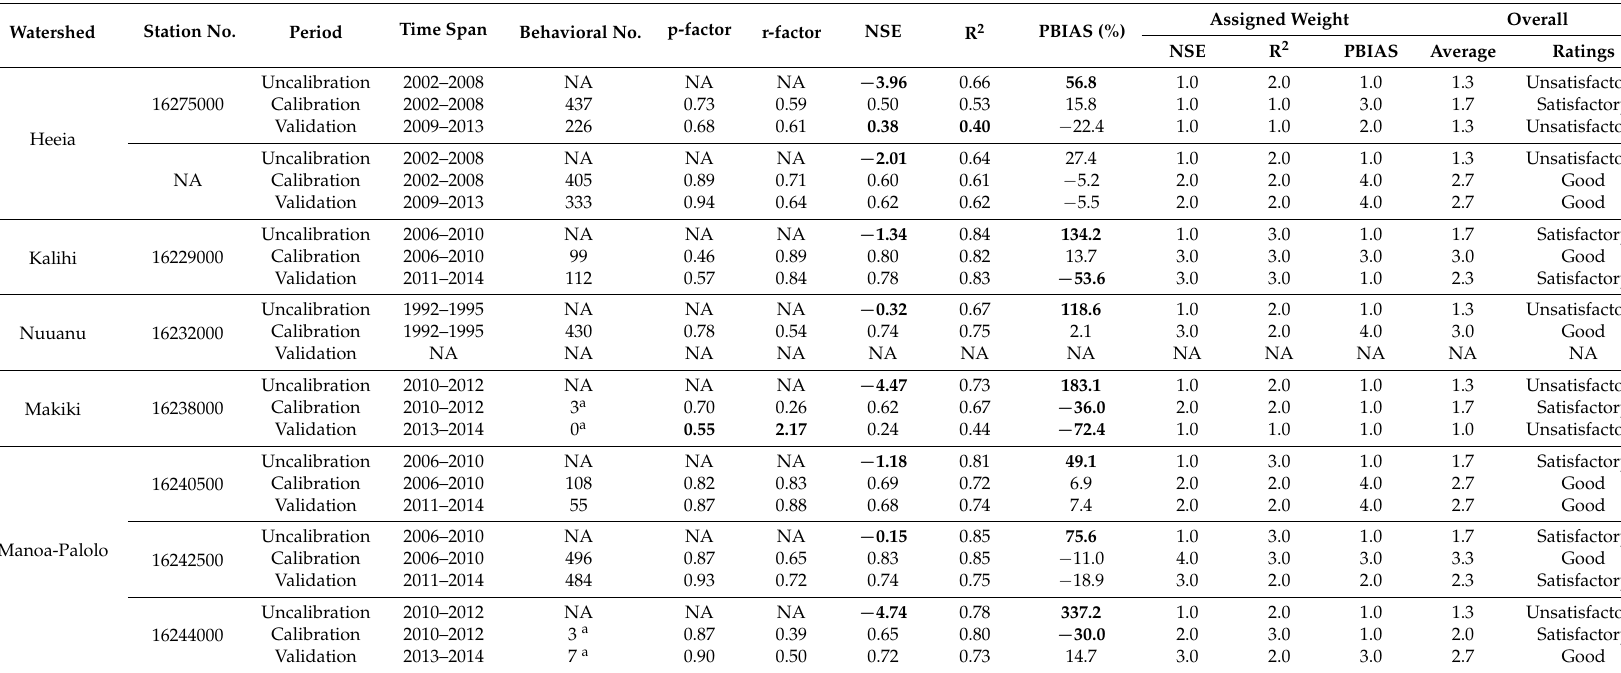
Table 6. Goodness-of-fit statistics for daily streamflow simulations at Heeia and Nuuanu area watersheds using UH250m rainfall data. Bold signifies unsatisfactory.